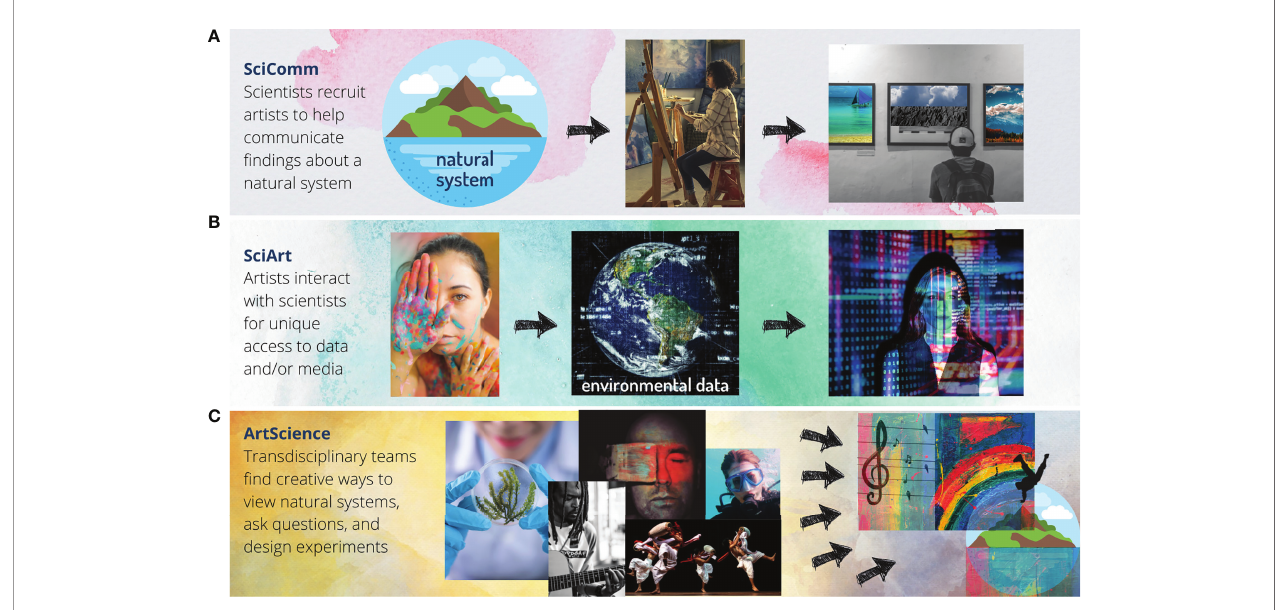
FIGURE 1 | Overview of three different dimensions of art-science collaborations. SciComm (A) , is the dimension in which artists interpret scienti fi c fi ndings to communicate with broader audiences. SciArt (B) refers to artists interacting with scientists to gain access to data and scienti fi c knowledge. ArtScience (C) refers to a dimension of art-science collaboration where transdisciplinary teams, including researchers and artists, explore creative approaches for viewing natural systems, asking questions, designing experiments and translating knowledge into action. These dimensions are not mutually exclusive; a single project may include one or more (Created using free content from Canva.com,